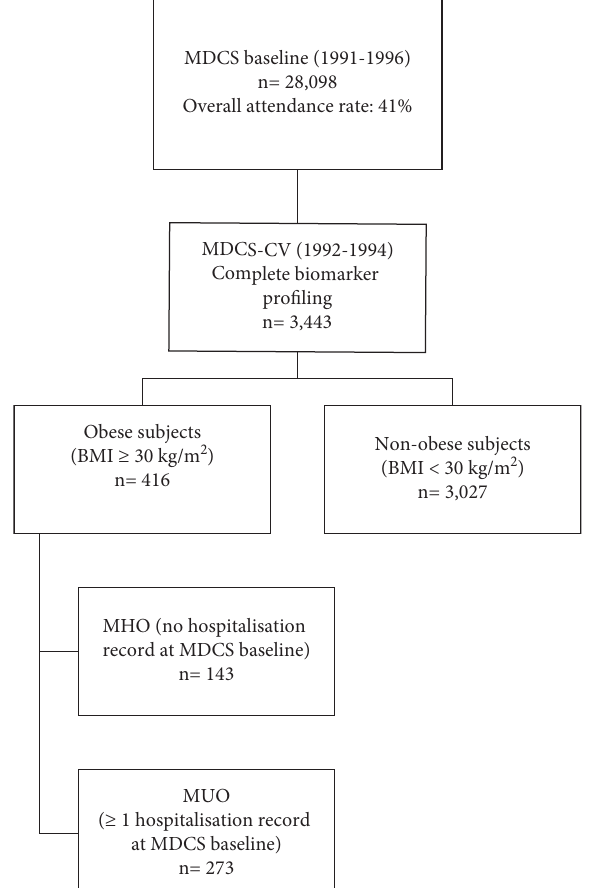
Figure 1: Flowchart of the MDCS-CV subcohort stratified for obese and nonobese subjects,